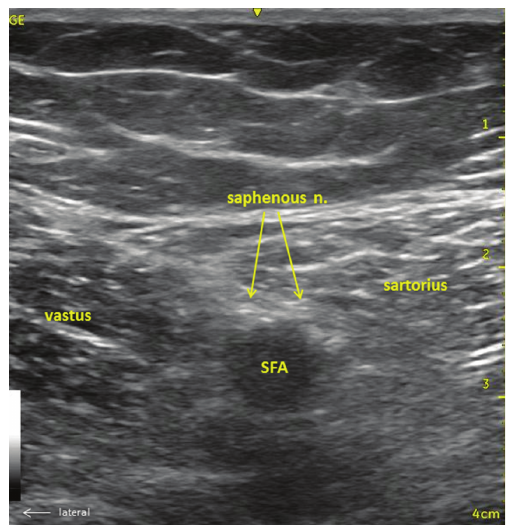
Figure 1: Sonoanatomy of saphenous nerve at mid-thigh.